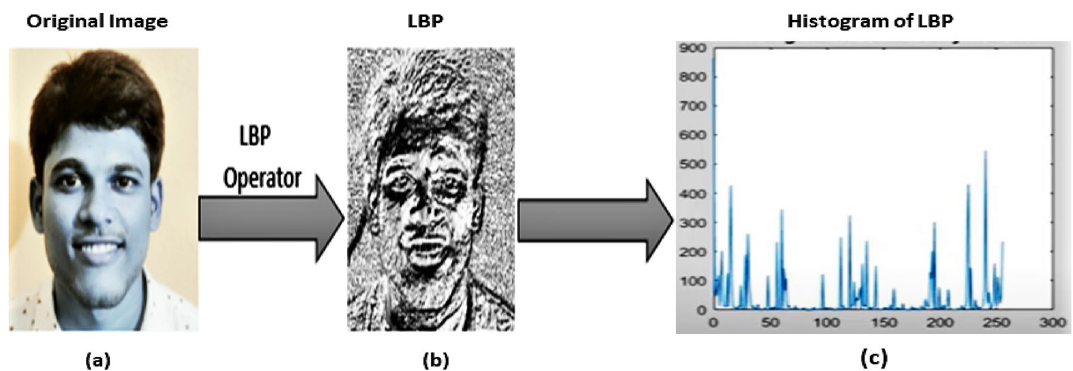
Figure 13. ( a ) The detected face from original image. ( b ) LBP of image. ( c ) Feature histogram of LBP image. . (Figure adapted from our own test images 39 ).